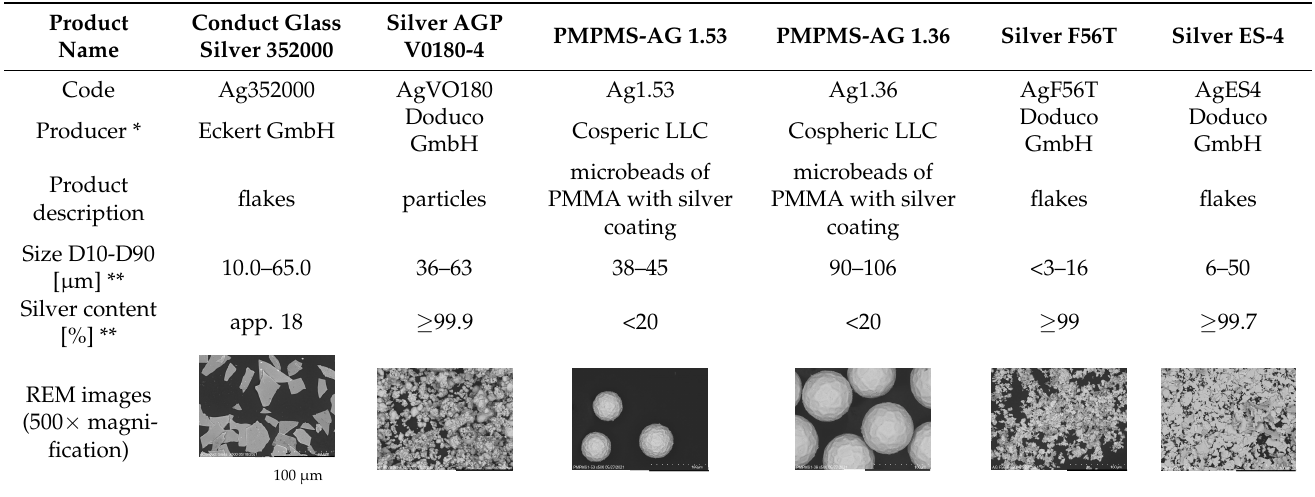
Table 1. Information on added filler materials.